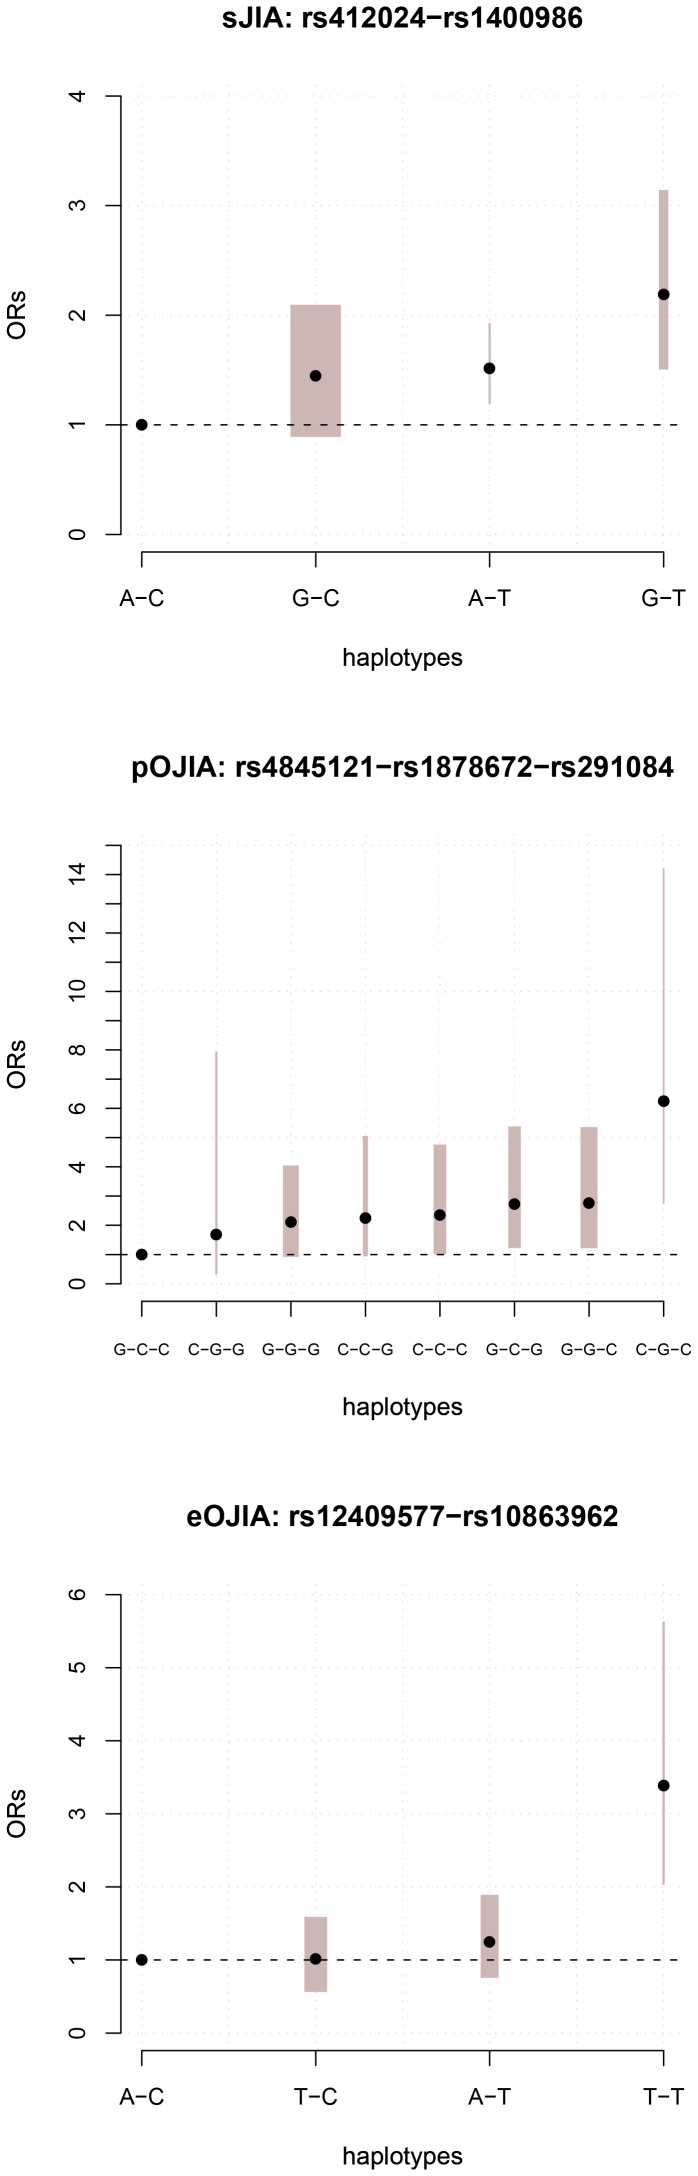
Odds ratios for each haplotype in the best-fitting model for each JIA subtypes, with 95% CI (grey band, with width proportional to haplotype frequency in controls).